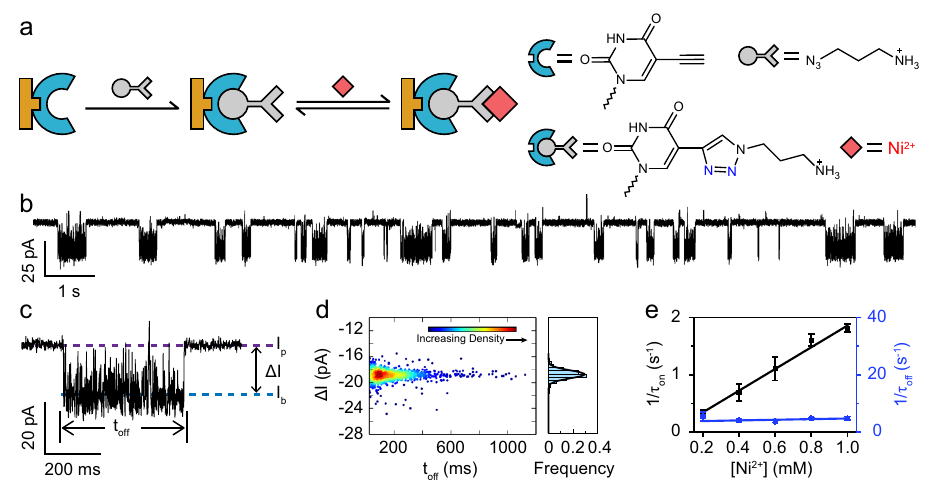
Fig. 2 PNRSS with unnatural reactive components. a The introduction of a 1,2,3-triazole (TAZ) to the PNRSS strand and its reaction mechanism. The PNRSS strand 14TAK (Supplementary Table 1) was reacted with 3-azidopropylamine, as described in Supplementary Fig. 11. The generated TAZ serves as the fi xed reactant. Ni 2 + , the mobile reactant, becomes involved in reversible coordination with a TAZ. b Trace demonstration. A continuous trace containing Ni 2 + -binding events. Characteristic noise fl uctuations were consistently observed during Ni 2 + binding. c A representative event. A zoomed-in demonstration of a binding event. Noise fl uctuations during Ni 2 + binding indicate possible reactive intermediates observable by PNRSS. d Density scatter plot of 4 I vs. t off . The colour scale represents the local density around each point. The density scatter plot was generated using the ggplot2 package of R. A highly uniform event population was observed. Results of 905 events are included. e Concentration dependence. The reciprocal of inter-event interval (1 = τ on ) and the reciprocal of dwell time (1 = τ off ) is plotted against [Ni 2 + ] (Supplementary Table 6). The measurement was carried out as described in ‘ Methods ’ . Nickel sulfate was added to trans at the desired fi nal concentration. Error bars = SD ( N =